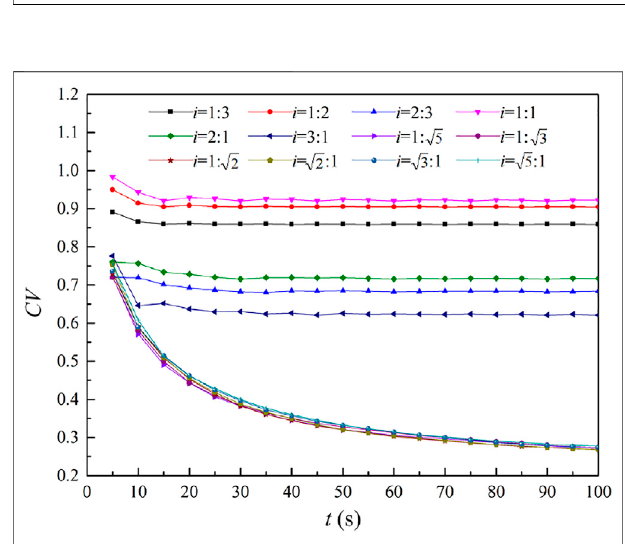
FIGURE 4 | Distribution of particle trajectories on the target surface under i (cid:1) 1 :